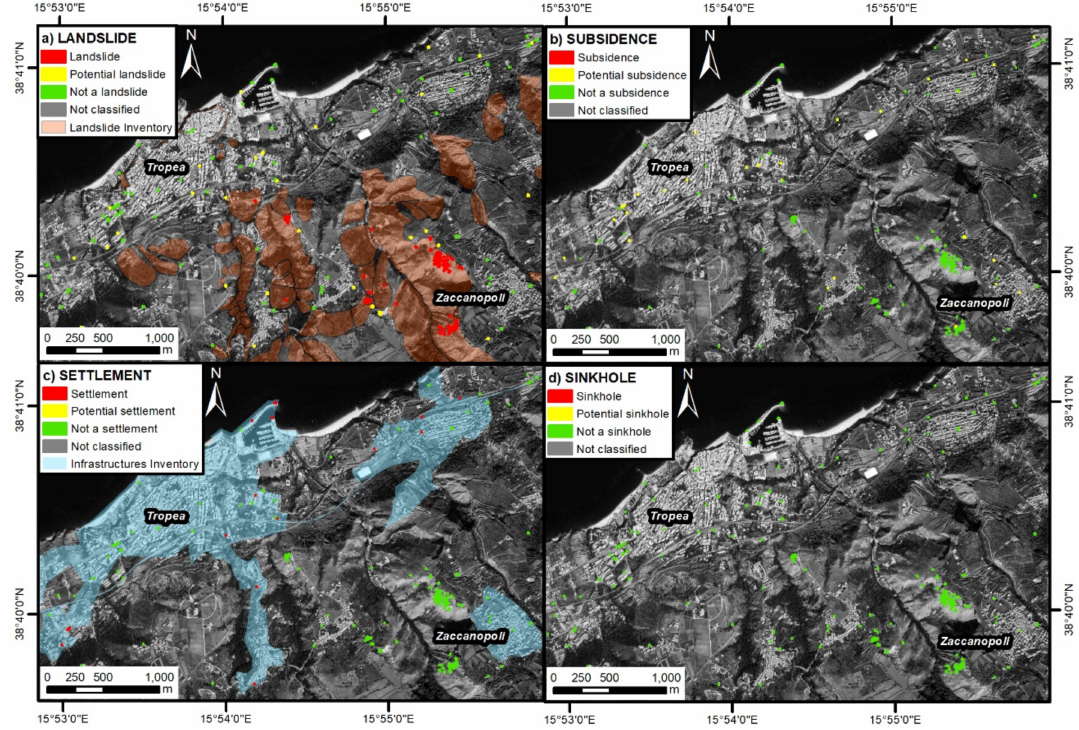
Figure 16. Classification of active deformation areas (ADA) in the study area of Tropea-Zaccanopoli as: ( a ) landslides; ( b ) subsidence; ( c ) consolidation settlements; and ( d )